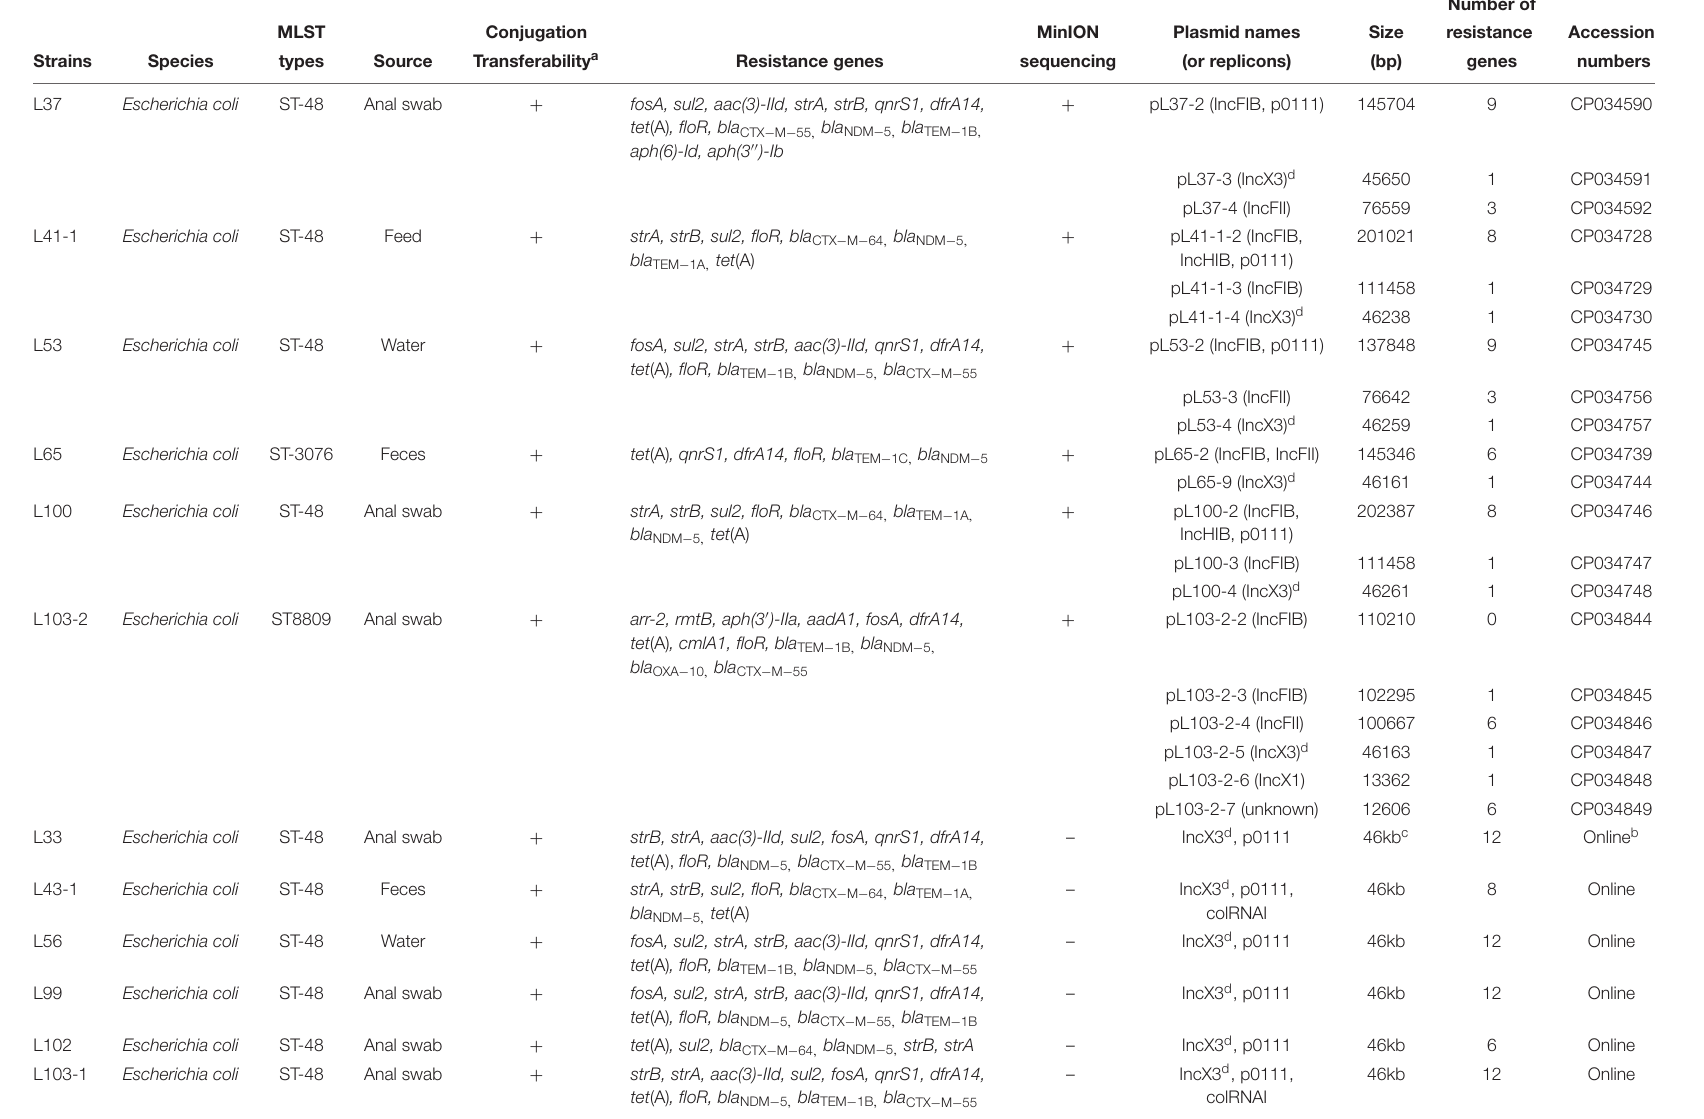
TABLE 2 | Basic information of the twelve bla NDM − 5 positive E. coli strains revealed by WGS